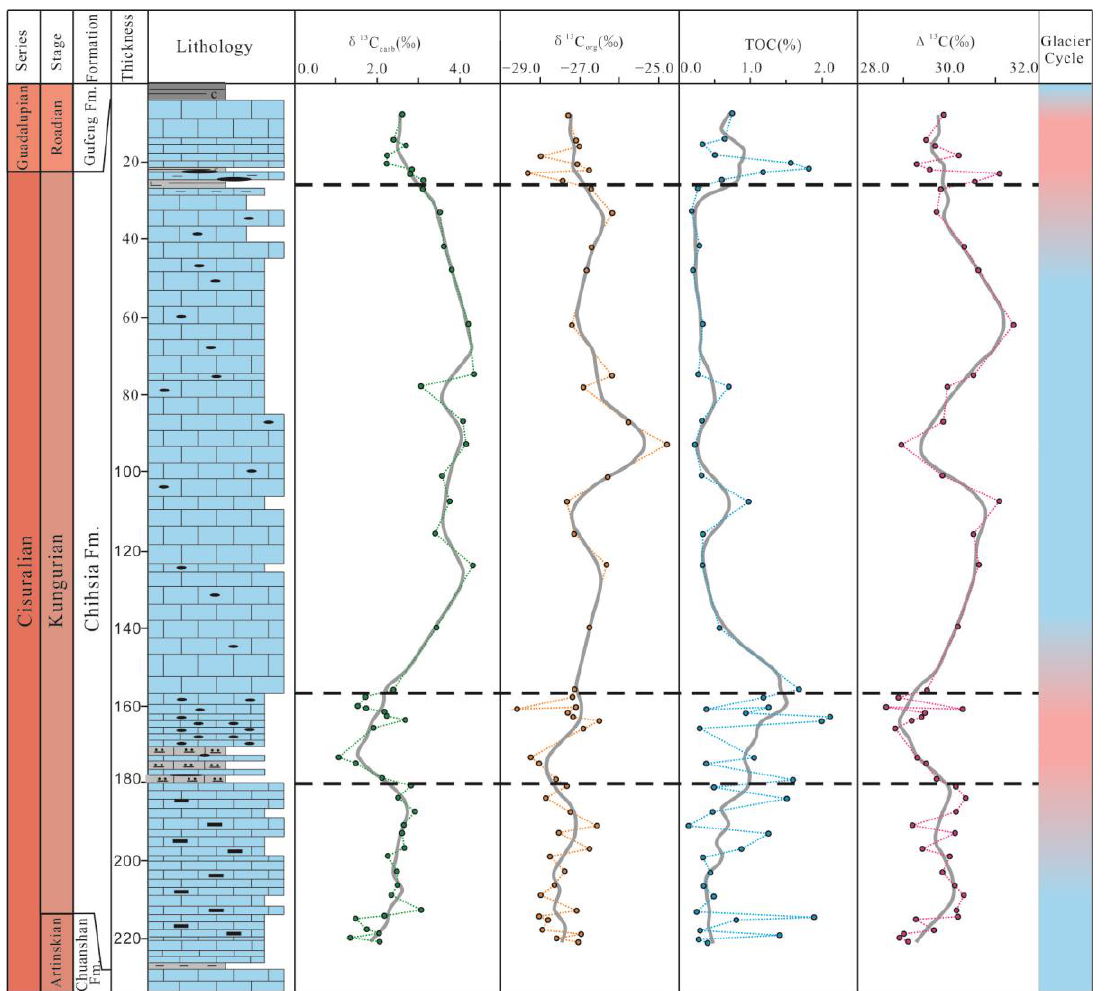
Figure 4. The variation relationship of 13 C carb , 13 C org , TOC, and Δδ 13 C at the Putaoling section during the Kungurian. The solid curves of the 13 C carb , 13 C org , TOC, and Δδ 13 C values in the Putaoling section are 3-point running averages.